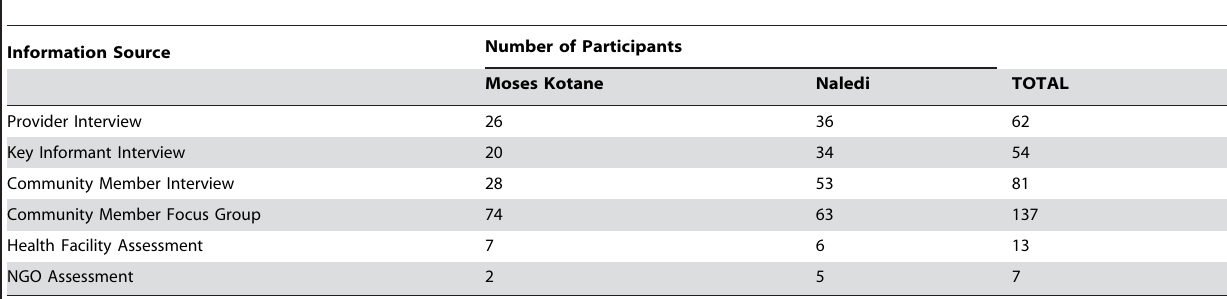
Table 2. Number of participants in Interviews, Focus Groups and Assessments, by place and type.